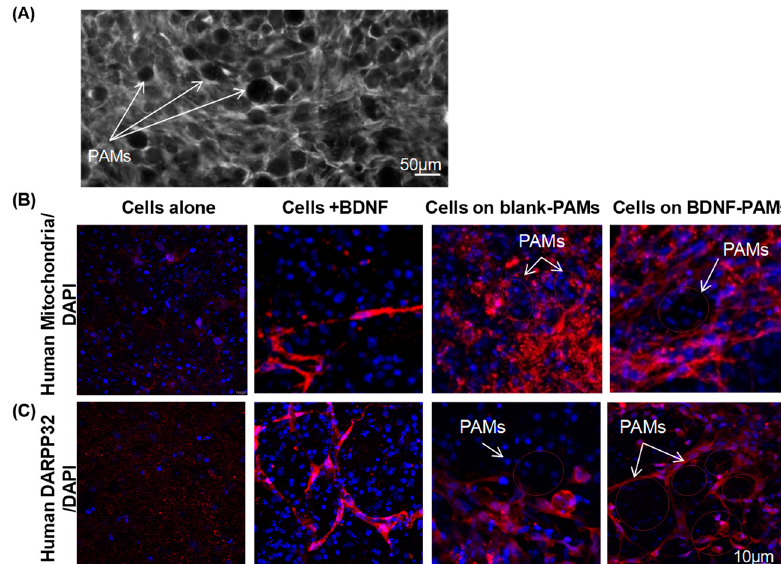
Figure 7. Behavior of MIAMI-SHH-siREST grafted into an ex vivo model of HD. ( A ) Black and white picture at lower magnification showing the PAMs with the transplanted cells within the tissue. All the cells are visualized by DAPI staining and the transplanted cells by immunohistofluorescence against human mitochondria. ( B ) Immunohistofluorescence against human mitochondria (in red) and ( C ) human DARPP32 (in red) for MIAMI cells 14 days after grafting, either alone, or exposed to BDNF for three days before grafting, or on LM-blank PAMs for three days before grafting or on LM-BDNF PAMs for three days before grafting. Red circles were suggested on the images to emphasize the localization of PAMs. DAPI staining (in blue) was used to visualize all the cells. Scale bar is 10 µm.